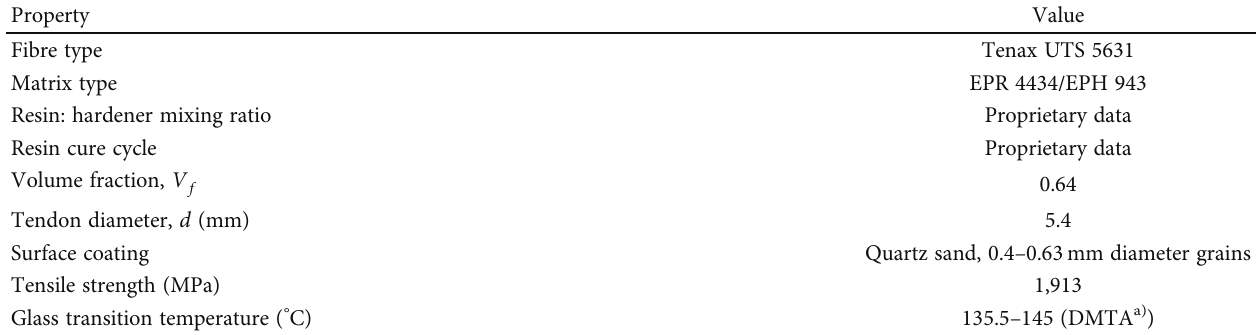
Table 2: Properties of epoxy resin and CFRP tendons